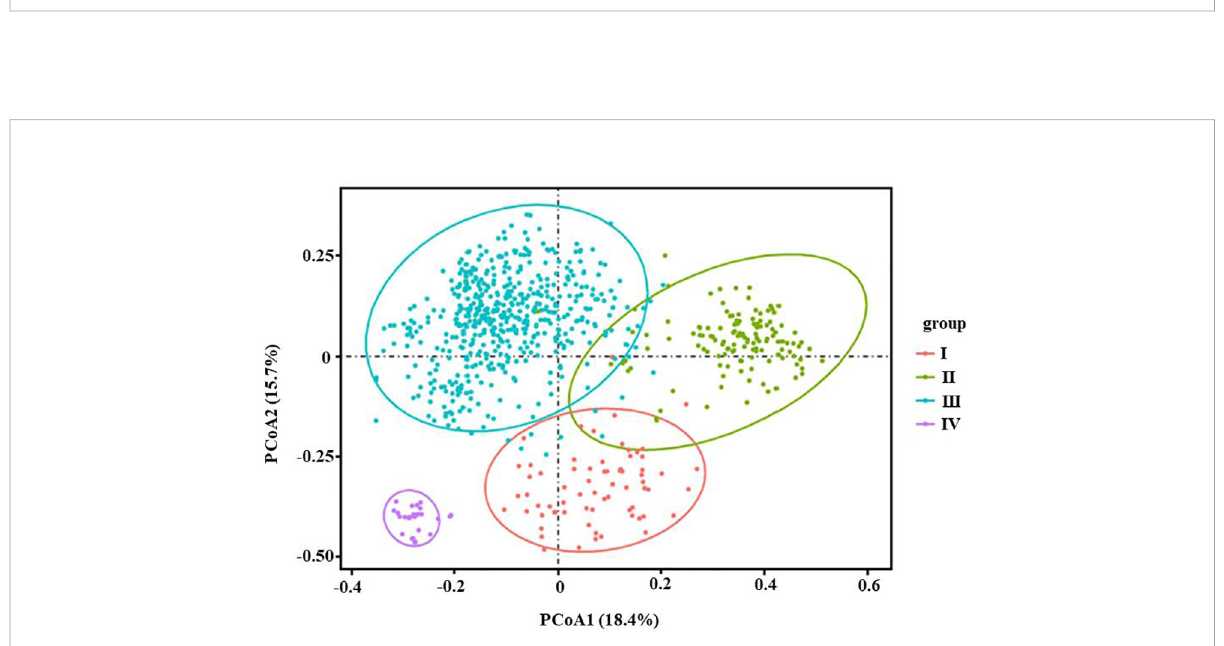
FIGURE 4 Principal coordinate analysis (PCoA) of 38 populations of 905 individuals of Wikstroemia monnula based on Nei ’ s unbiased genetic distances. Horizontal (PCoA1) and vertical (PCoA2) scales represent the fi rst and second principal axes of variation respectively (PCoA1 and PCoA2 that explain the most variations among populations). Here PCoA1 represents a large 18.4% of variation, the PCoA2 represents 15.7% of variation, and 38 populations of W. monnula could be divided into four different groups. Group I: P2, P10, P17 and P31 (105 individuals); Group II: P3, P6, P7, P8, P12, P18, P21, P38 and P39; Group IV P33 and P34; group III: other 23 populations.